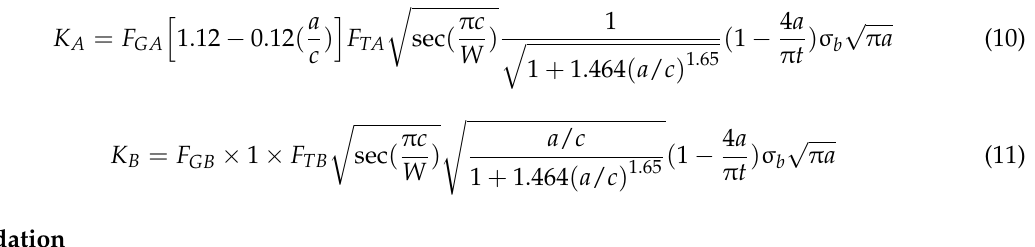
Figure 14. Modified formula vs. the Raju-Newman solution at point A ( c / W = 0.1). Figure 15. Modified formula vs. the Raju-Newman solution at point B ( c / W = 0.1).